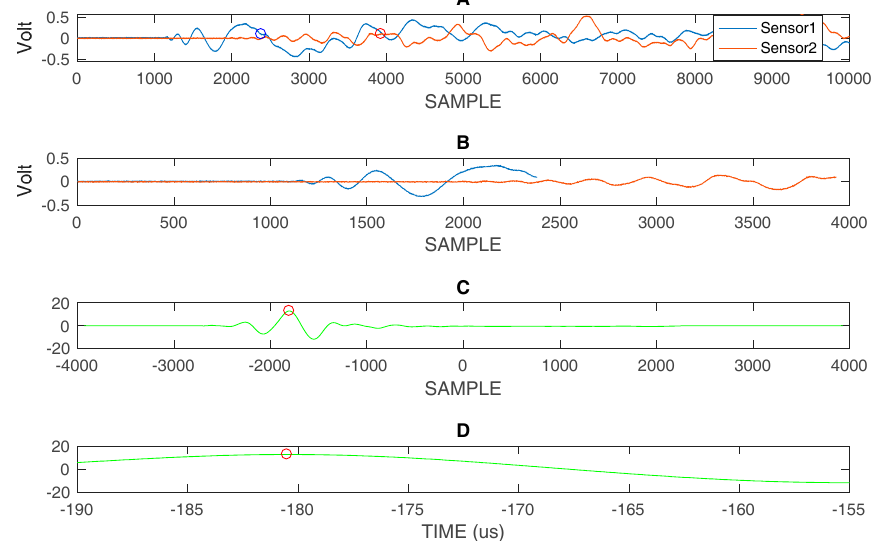
Figure 9. ( A ) impact #3: acquired signals sensor 1 and sensor 2 with marked positions by circles indicating the end of the time window used for further processing, ( B ) selected time window, ( C ) correlation evaluated with the two selected signals shown in ( B ), ( D ) zooming of correlation in ( C ) and representation on time scale: DToA = − 180.5 µs. Ts = 40 ns.